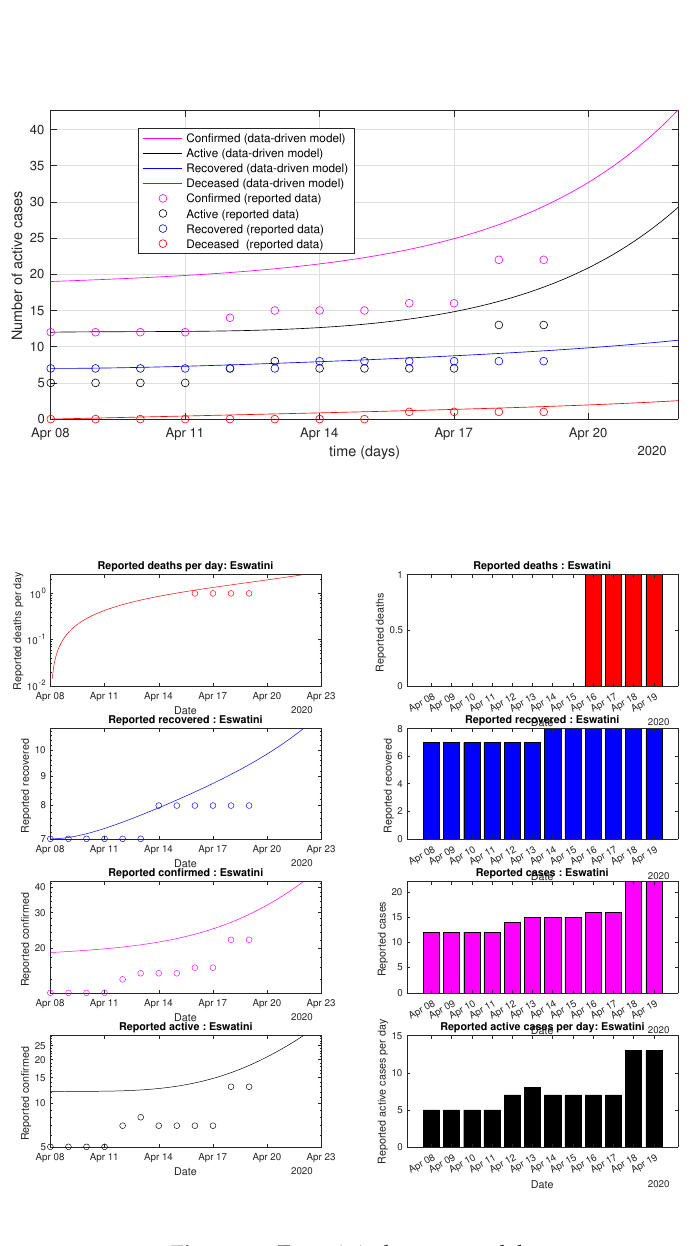
Figure 61. Eswatini: data vs.